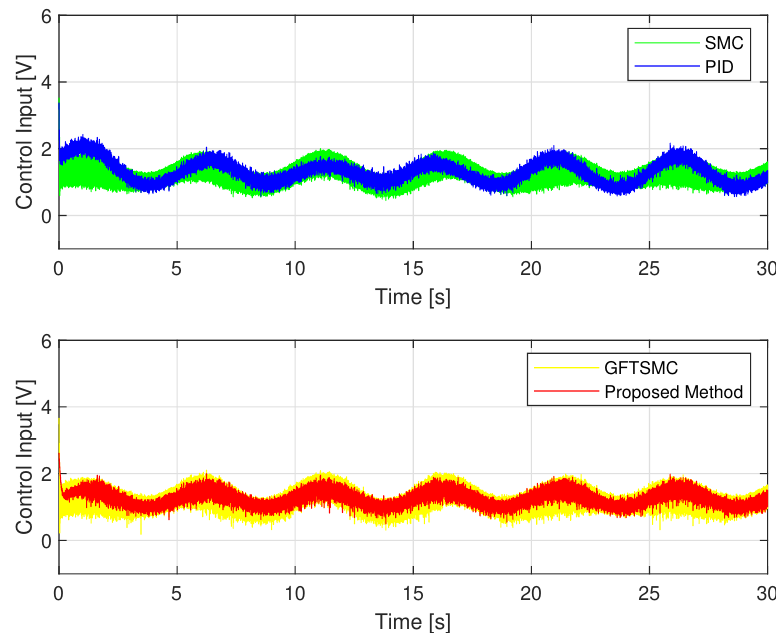
Figure 9. Time evolution of control voltage from four control